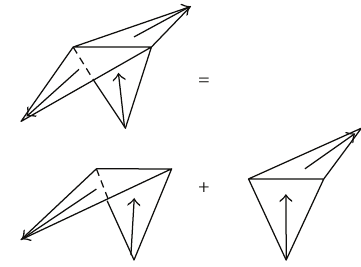
Figure 3: Division fashion of pair of triangles in